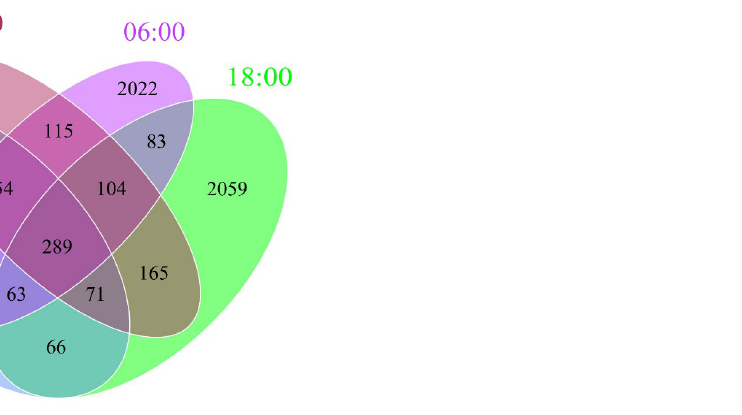
Figure 2. Venn diagram showing the number of unique and shared ASVs among the different sam- ple times.